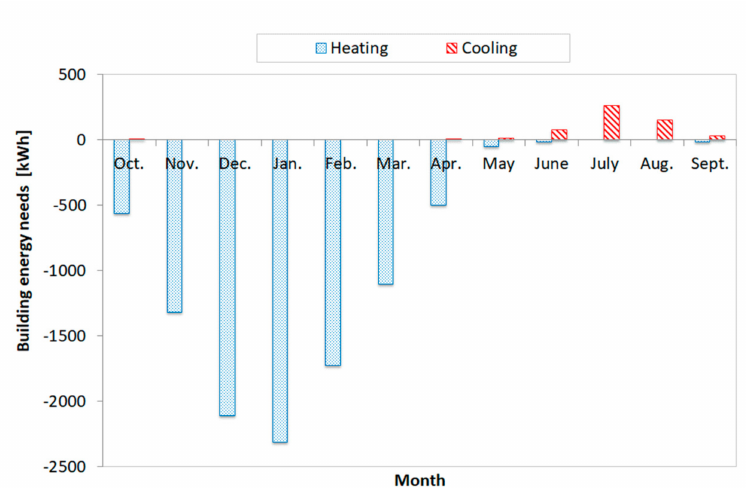
Figure 1. Simulated monthly energy needs of the